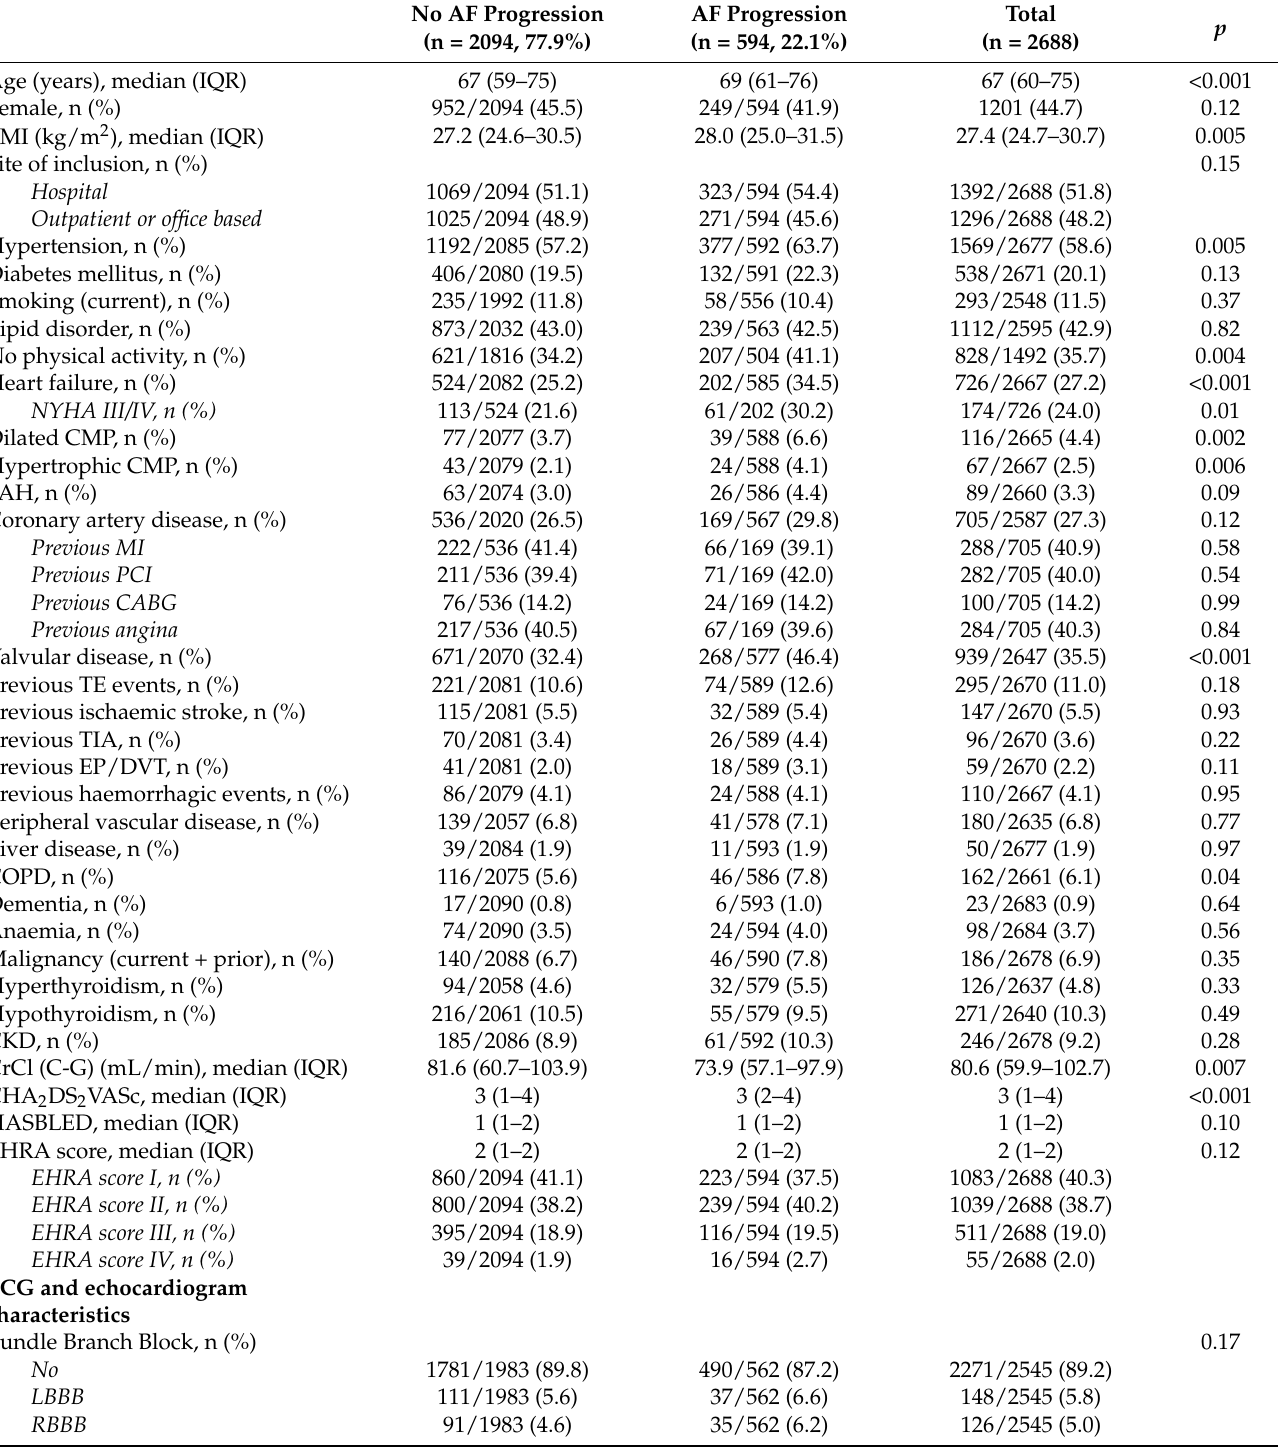
Table 1. Baseline